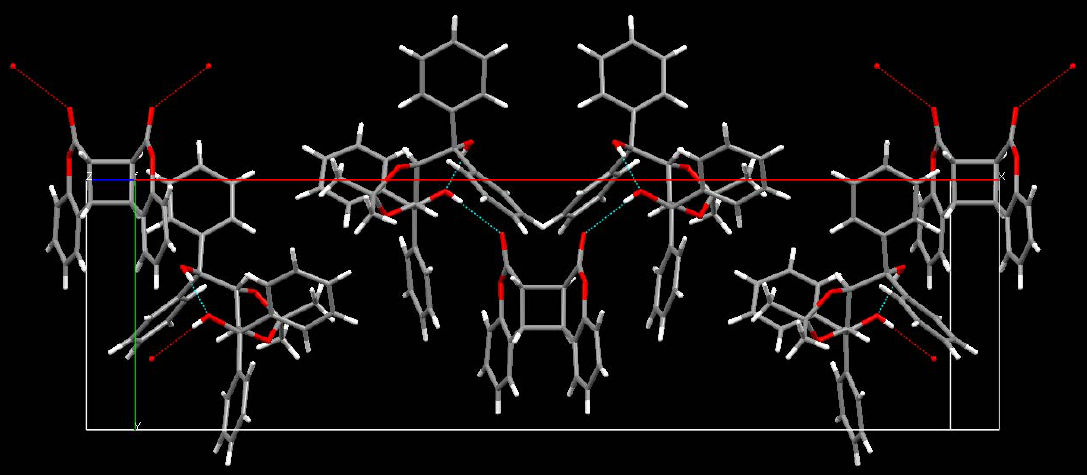
Figure 2. X-ray structure of the 2:1 complex of (  )- 23 and the optically active anti–head–head dimer (  )- 2 .